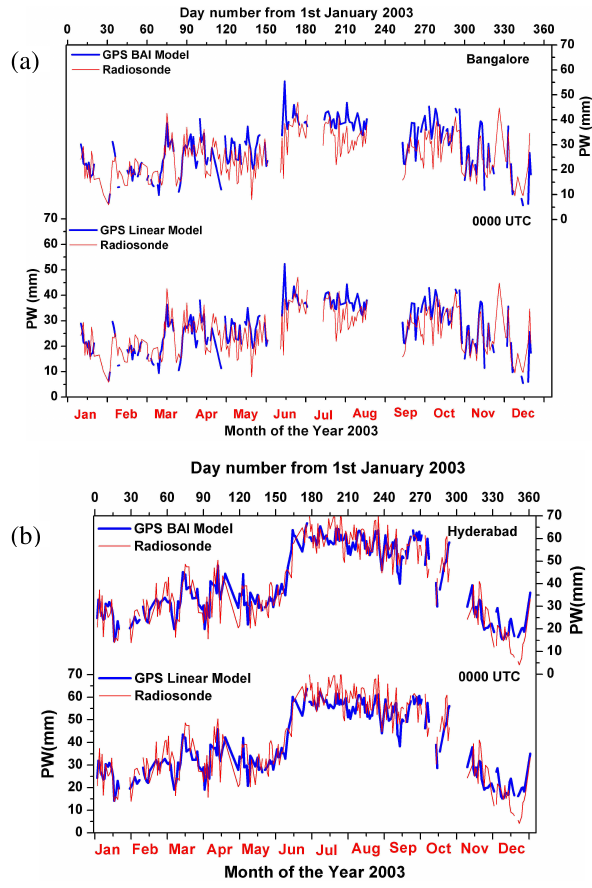
Fig. 12. Daily PW estimated from GPS data for the year 2003 using BAI regional model and site-specific linear model along with those derived from radiosonde data at 00:00 UTC, for Bangalore (a) and same for Hyderabad (b)